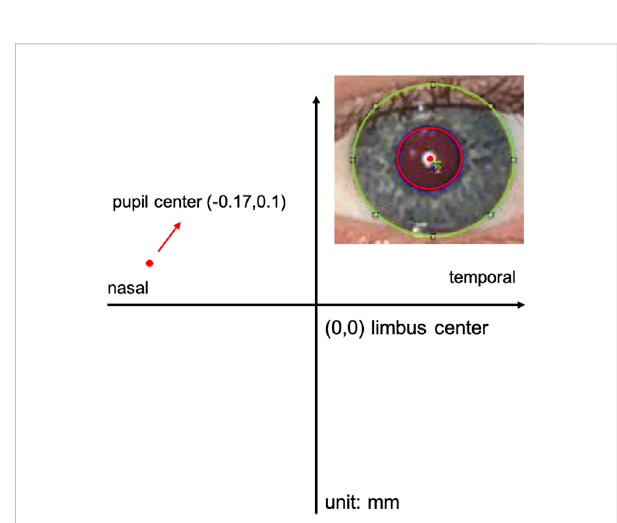
FIGURE 2 A good quality image is processed using Image J. The limbus and pupil of one eye can be accurately marked by Image J. Limbus center was considered as Origin (0, 0), and marked by green cross. Pupil center was marked by red